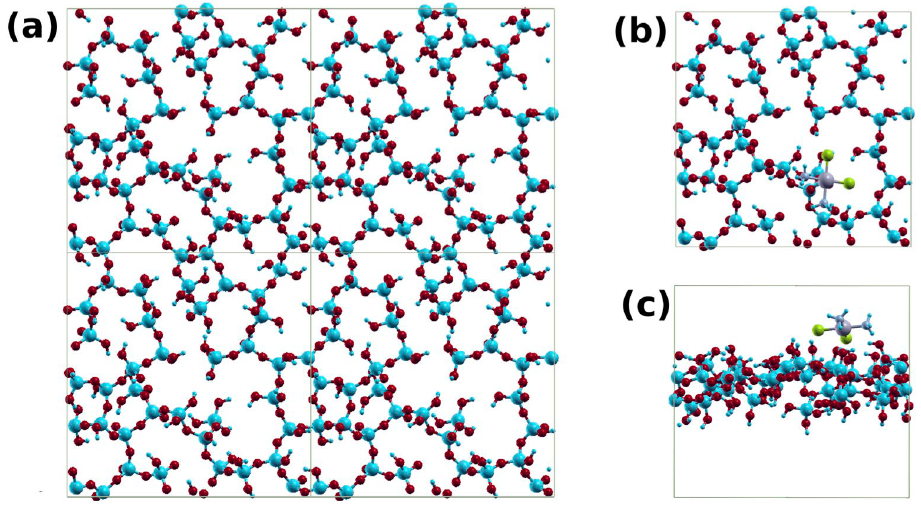
Figure 4. ( a ) A 2 × 2 supercell of the silica system; ( b ) top; and ( c ) side views of the cisplatin–silica structure.